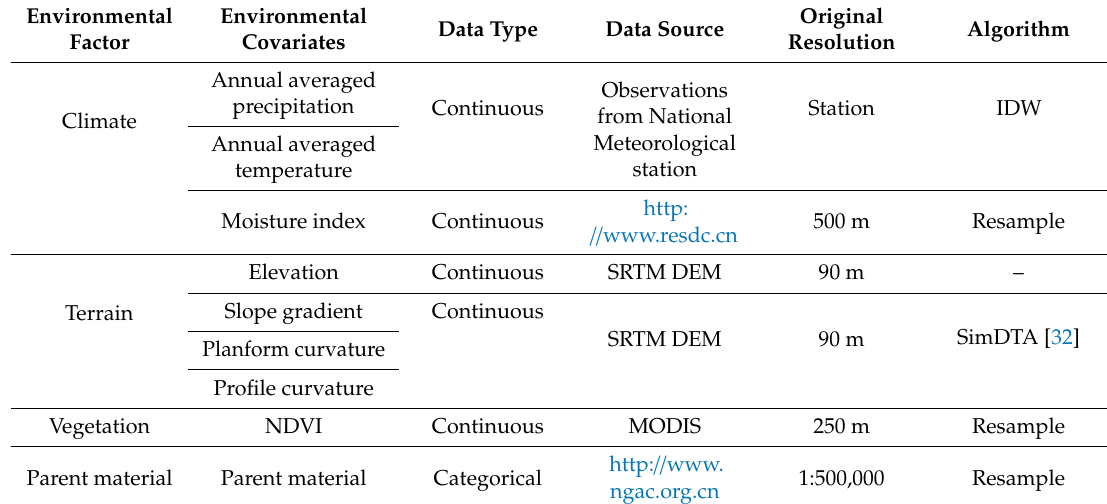
Table 1. Environmental covariates used in the case